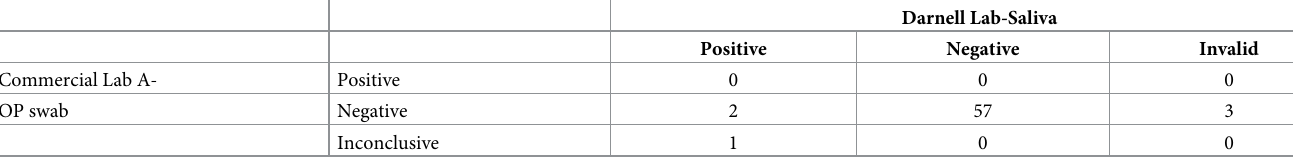
Table 2. Comparison of SARS-CoV-2 DRUL assay with commercially tested OP